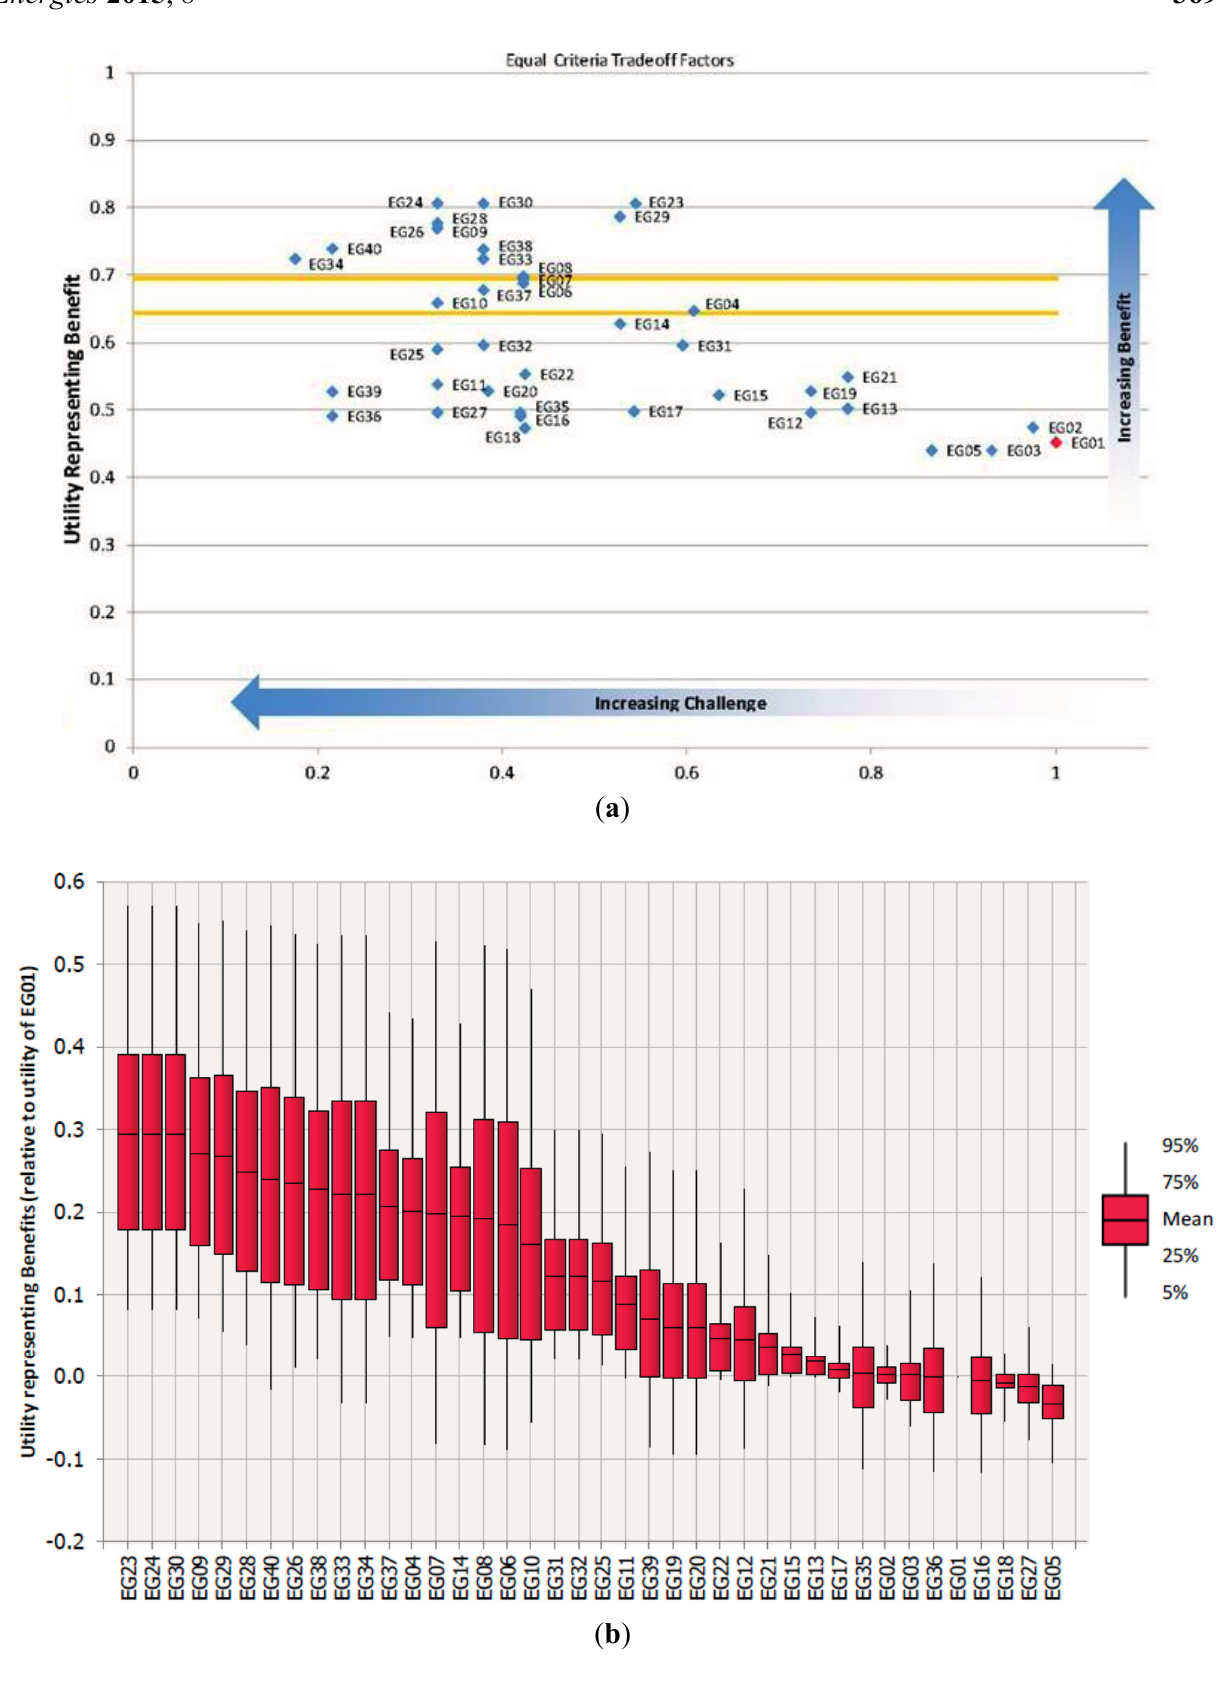
Figure 4. Considered NFCs and evaluation results. ( a ) Benefits vs. challenge; ( b ) Utility representing